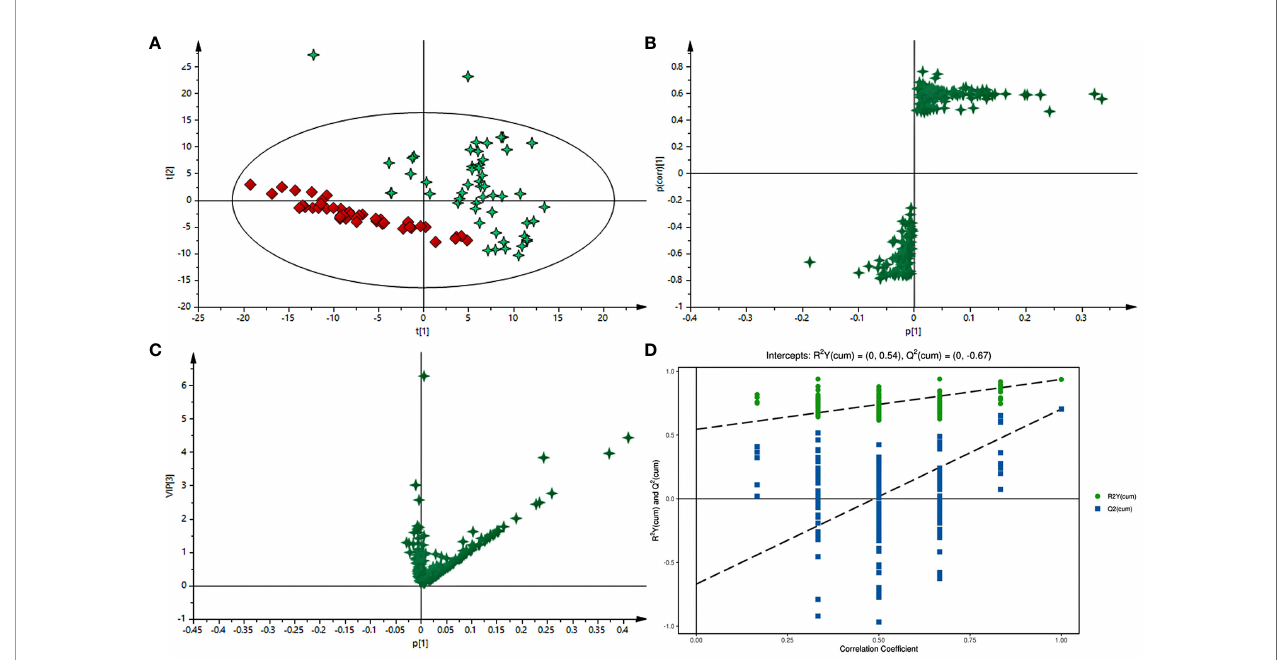
FIGURE 3 | (A) PCA score plot of cancer tissue and paracarcinoma tissue samples in positive-ion mode with the statistical parameters (R 2 X = 0.964, Q 2 = 0.897). (B) S-plot of OPLS-DA with the statistical parameters in positive-ion mode (R 2 X = 0.940, R 2 Y = 0.756, Q 2 = 0.743). (C) VIP value plot between cancer tissue and paracarcinoma tissue samples in positive-ion mode. (D) Validation plot of the cancer tissue and paracarcinoma tissue samples in positive-ion mode obtained from 200 permutation tests.